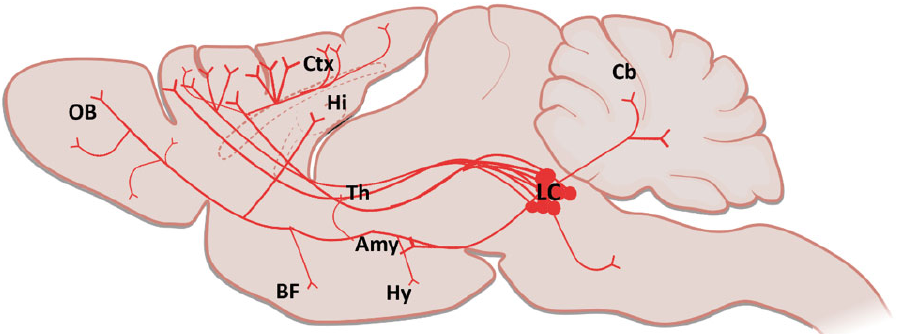
Figure 4. A sagittal schematic illustration showing the LC projections in the brain (Amy: Amygdala; BF: Basal Forebrain; Cb: Cerebellum; Ctx: Cortex; Hi: Hippocampus; Hy: Hypothalamus; LC: Locus Coeruleus; Th: Thalamus, OB: Olfactory Bulb). Created partially with BioRender.com (accessed on 28 June 2021).